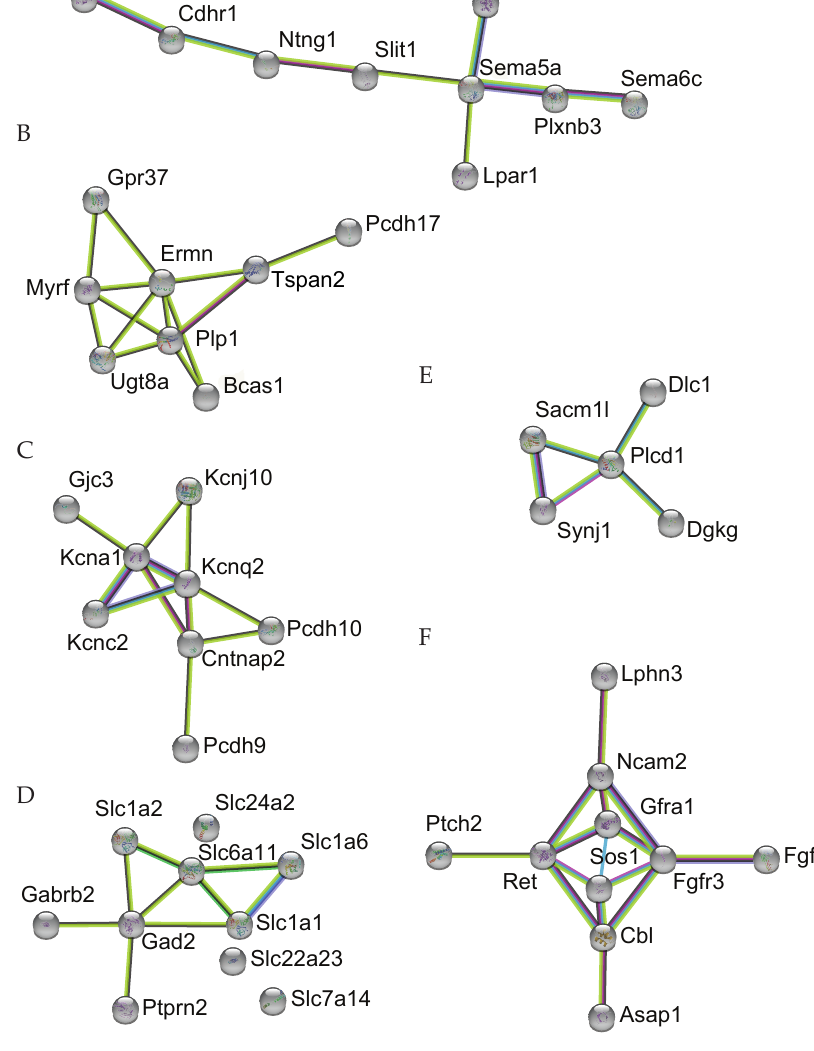
Figure 3. The cluster resulting from String analysis shown in Figure 2 was split into six groups on the basis of function. ( A ) Axon guidance genes (GO-MF GO:0007411). ( B ) Myelination-related genes (GO- BP GO:0042552). ( C ) Molecules related to voltage-gated potassium channels (GO-MF